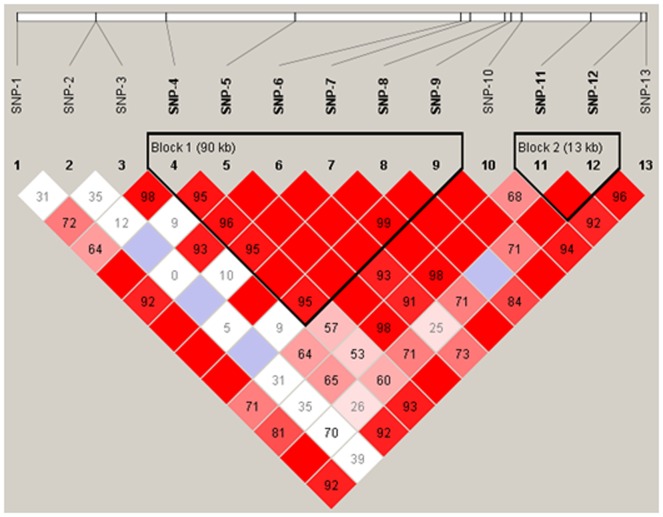
The haplotype blocks and pairwise linkage disequilibrium values (D’) for 13 SNPs in PTK2.The darker shading indicates higher linkage disequilibrium.